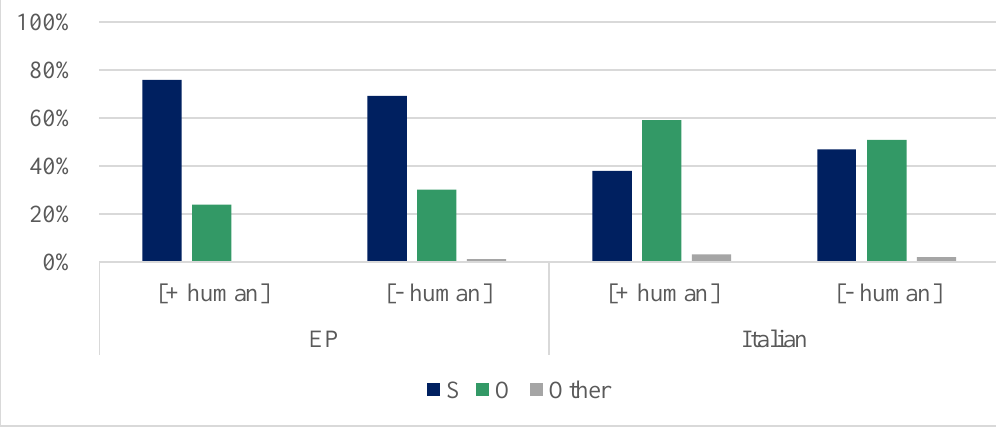
Figure 5. Interpretation of the null subject in the speeded task